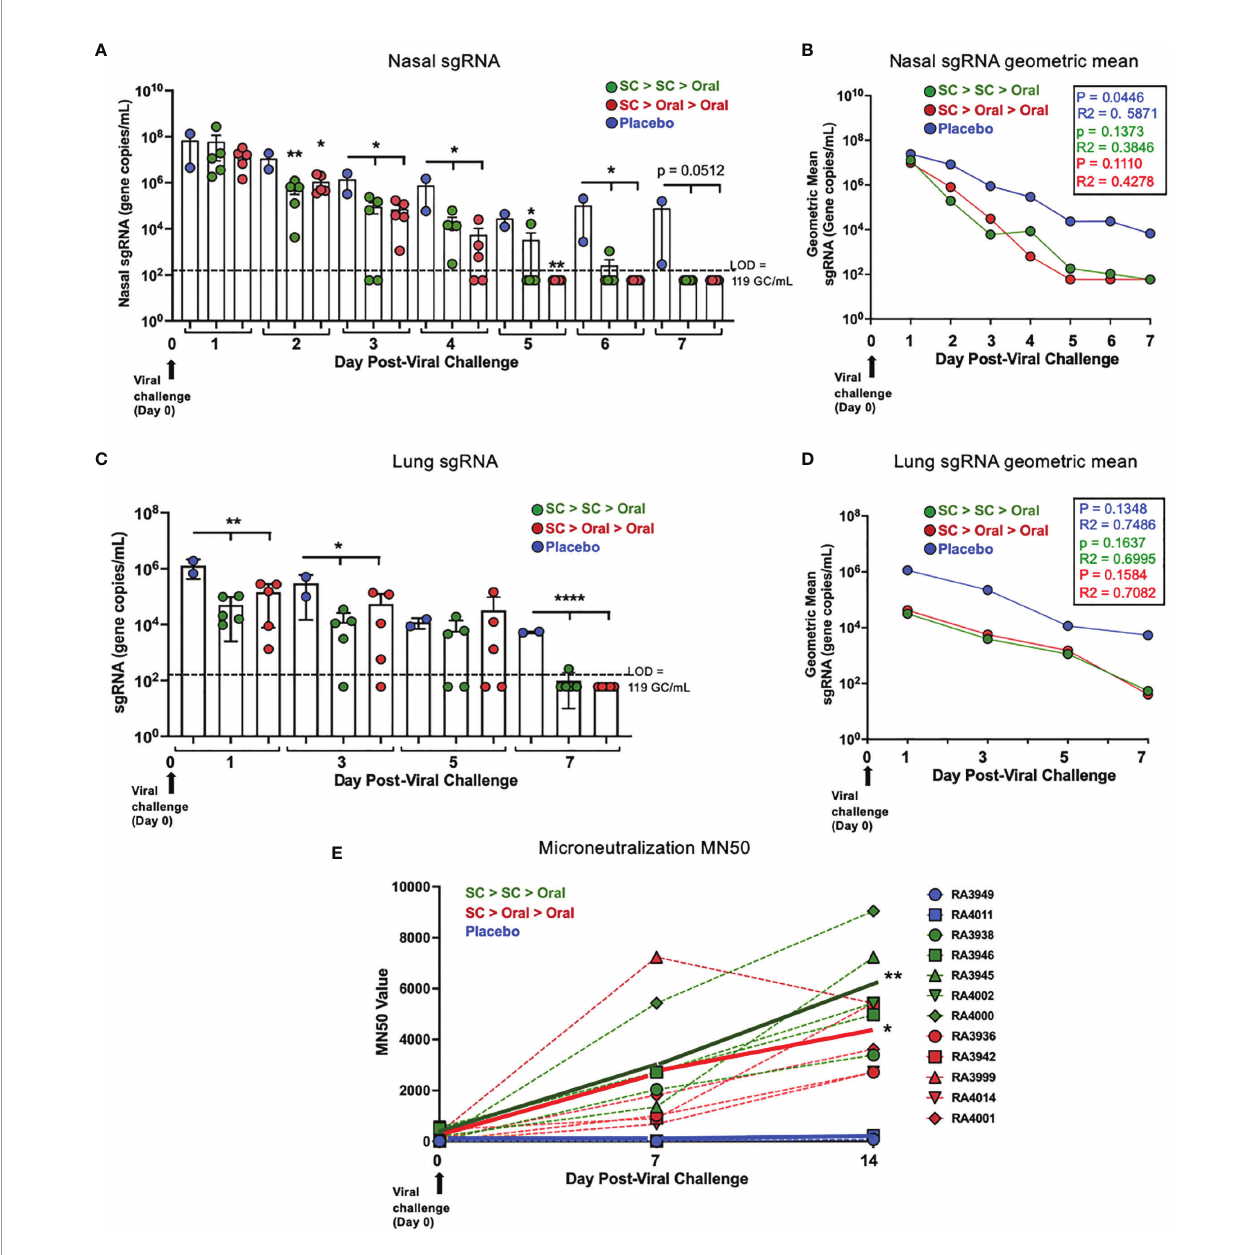
FIGURE 6 | Nasal and lung sgRNA and sera neutralization capability post-challenge. (A) Individual viral sgRNA and (B) the geometric mean for nasal samples; and (C) individual viral sgRNA and (D) the geometric mean for bronchoalveolar lavage (BAL) samples are shown. Data graphed as the mean and SEM in (A) and (C) The p and R 2 values are shown in (B, D) . The level of detection (LOD; dashed line) was 119 gene copies/mL (GC/mL) for sgRNA. For values below the LOD, half the LOD value (59 GC/mL) was used for graphing and calculation of the geometric mean. All statistical analyses performed using one-way ANOVA with Dunnett ’ s post- hoc comparison of vaccinated groups to placebo; where *p < 0.05, **p ≤ 0.01, and ****p ≤ 0.0001. For (A, C) , p values presented in Supplementary Table S7 . (E) Individual (dashed lines) and group (solid line) NHP sera microneutralization 50 (MN50) are shown for Day 0 pre-challenge and Days 7 and 14 post-challenge. On Day 14, p = 0.0047 and = 0.0423 for SC > SC > Oral and SC > Oral > Oral groups compared to placebo,